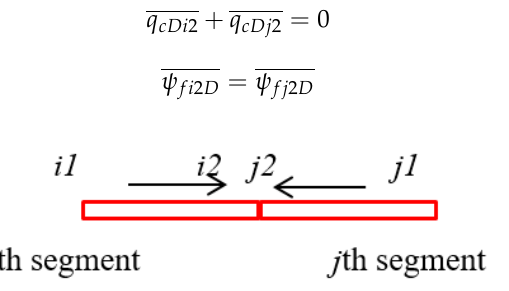
Figure 7. Illustration of fluid transferring in connecting vertex.